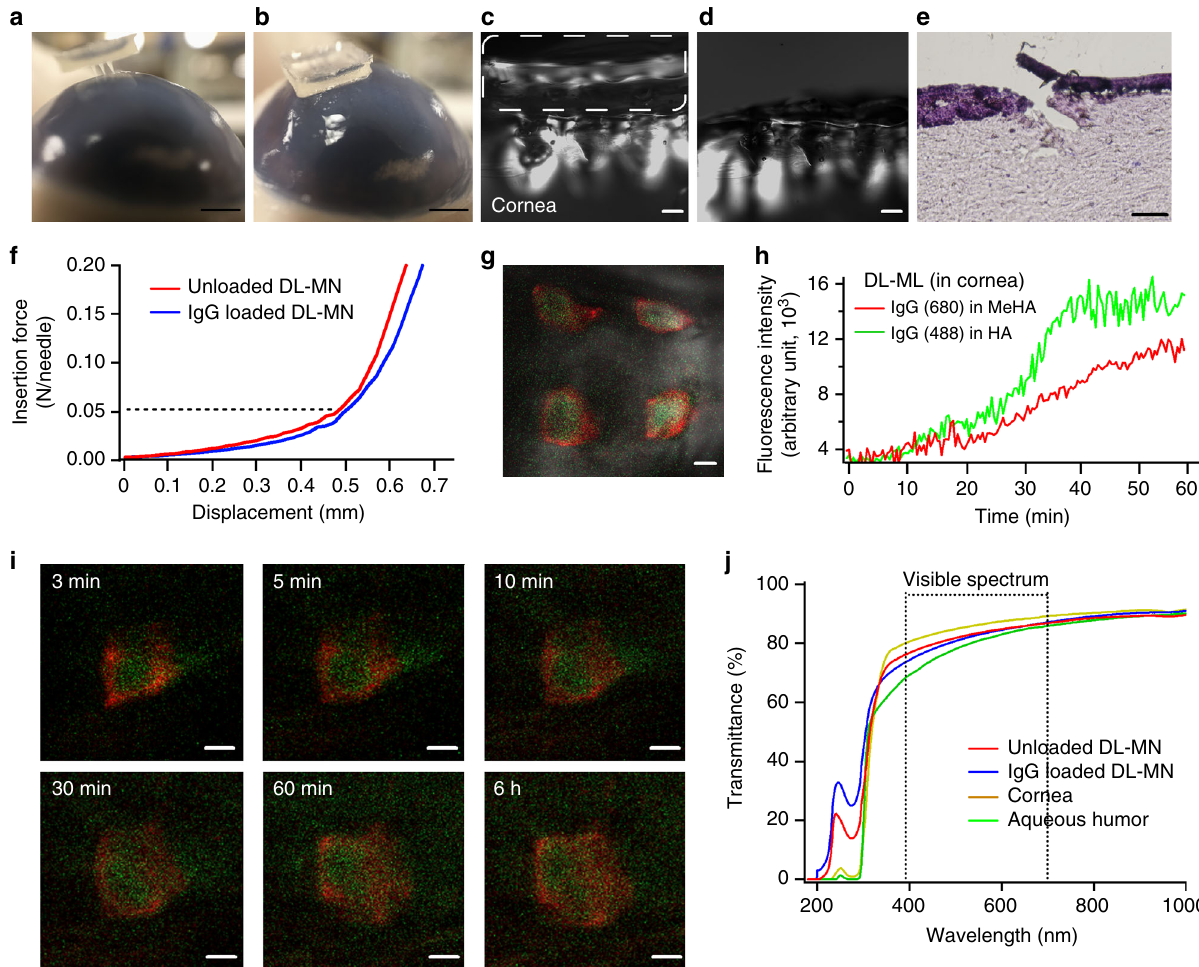
Fig. 5 Ex vivo studies of double-layered microneedles on porcine cornea. A polymeric patch containing 3×3 DL-MNs was applied on the central region of porcine eye (~30s). a , b Bright- fi eld images of the cornea before ( a ) and after ( b ) MN insertion. Scale bars = 2mm. c , d Bright- fi eld images of the cornea (cross-sectional view), upon MN insertion ( c ) and after removal of the supporting patch ( d ). Scale bars = 200 µ m. e Hematoxylin and eosin stained section of the cornea showing the cavity caused by DL-MN penetration. Scale bar = 100 µ m. f The averaged insertion force of DL-MN into the cornea ( n = 3). g – i Confocal image of embedded DL-MNs in cornea ( g ), the average fl uorescence intensity changes ( n = 4) in the region adjacent to DL-MNs ( h ), and confocal visualization of real-time release of IgG(680) (red colour) and IgG(488) (green colour) from DL-MN into the cornea ( i ). Scale bars = 100 µ m. j Transmittance of the fully-hydrated DL-MN, cornea and aqueous humour at different wavelengths ( n = 3). n represents the number of samples for each